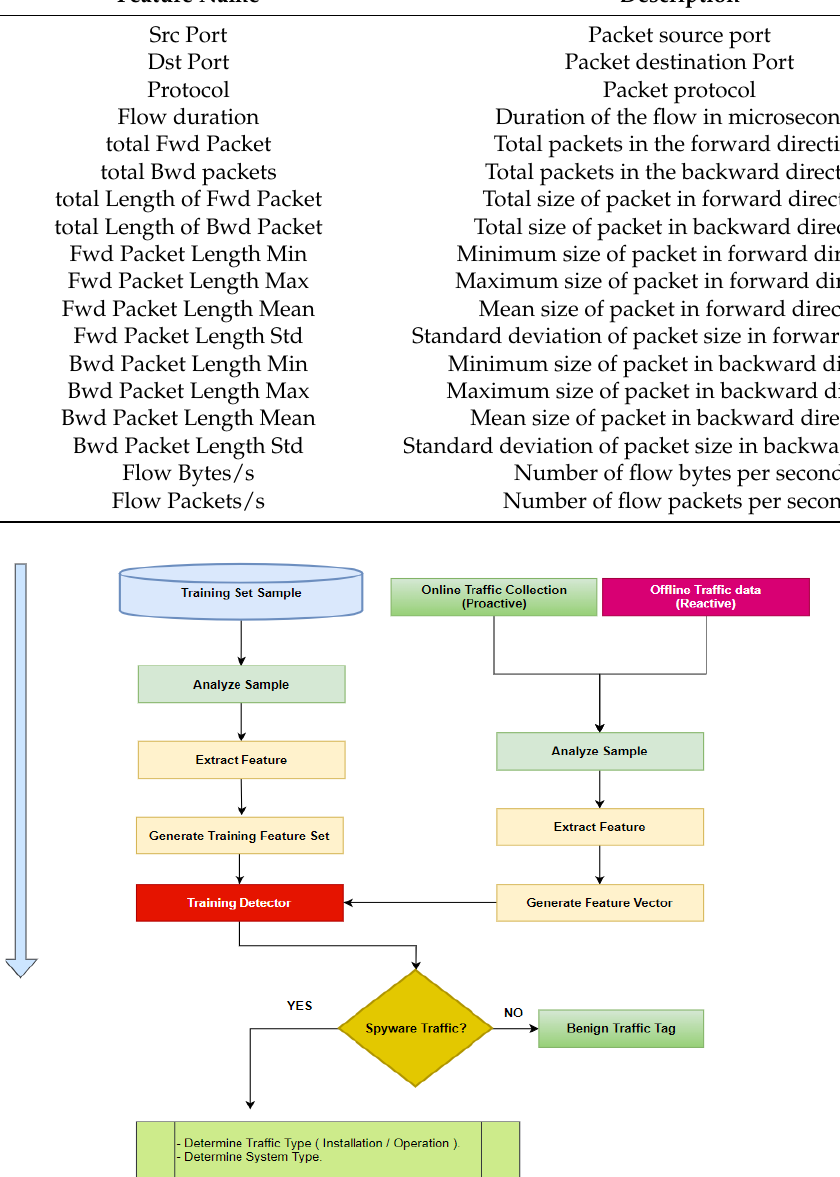
Figure 10. Proposed detection model flow diagram.